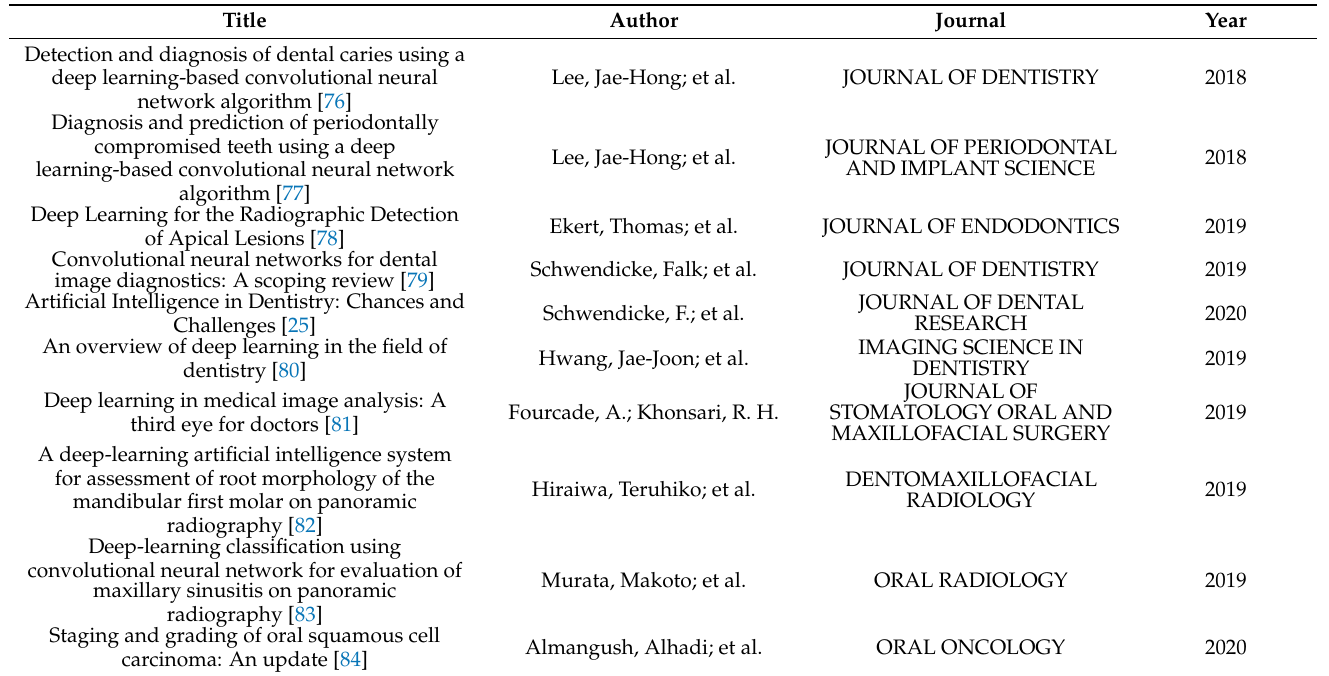
Table 5. The most impactful AI publications in